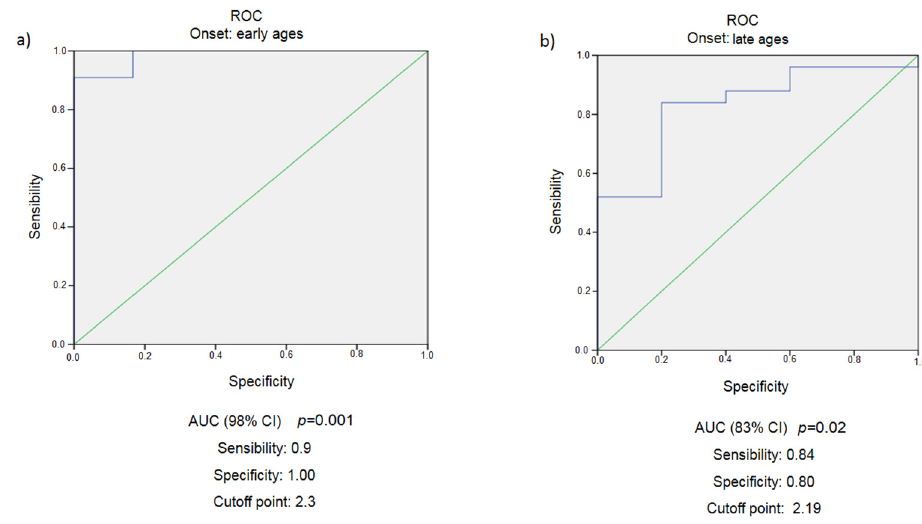
Figure 1. Receiver operating characteristic (ROC) curves of the TG/HDL-c ratio for ( a ) early ages (childhood) and ( b ) late ages (adulthood) of obesity onset.